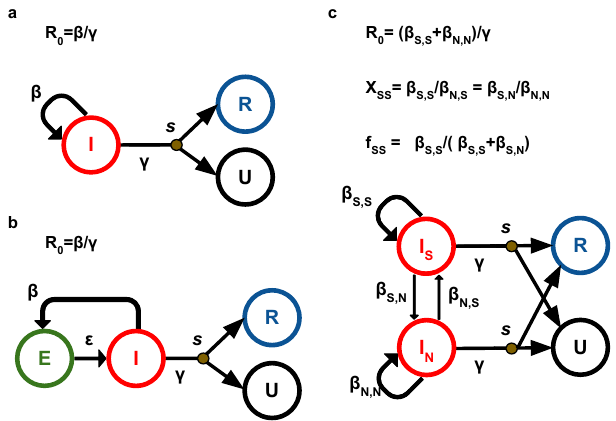
Fig. 1 Birth-death models. a Birth-death model (BD) 8,9 , b birth-death model with Exposed-Infectious individuals (BDEI) 5,10,11 and c birth-death model with SuperSpreading (BDSS) 5,12 . BD is the simplest generative model, used to estimate R 0 and the infectious period (1/ γ ) 8,9 . BDEI